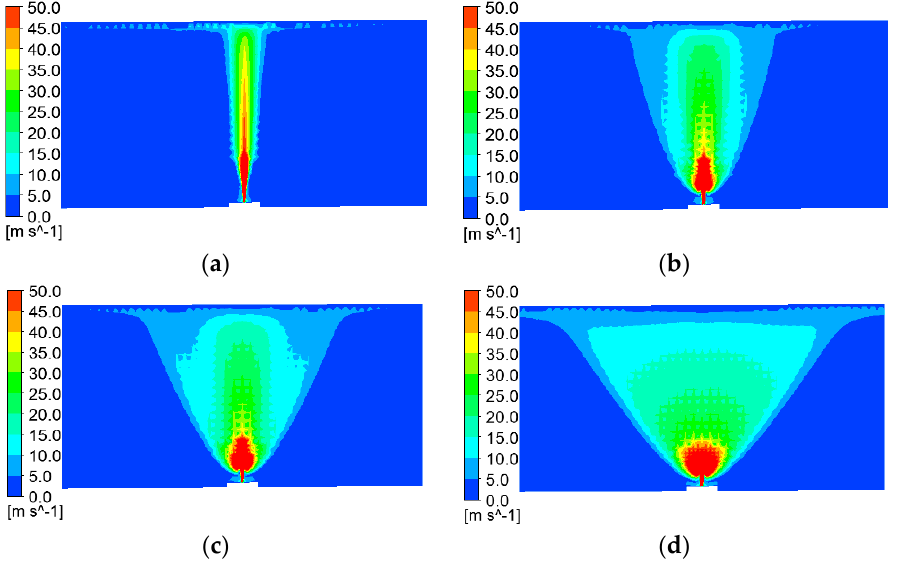
Figure 5. Velocity contours along the long axis for four shaping air pressures: ( a ) 0 MPa; ( b ) 0.02 MPa; ( c ) 0.05 MPa; ( d ) 0.07 MPa.